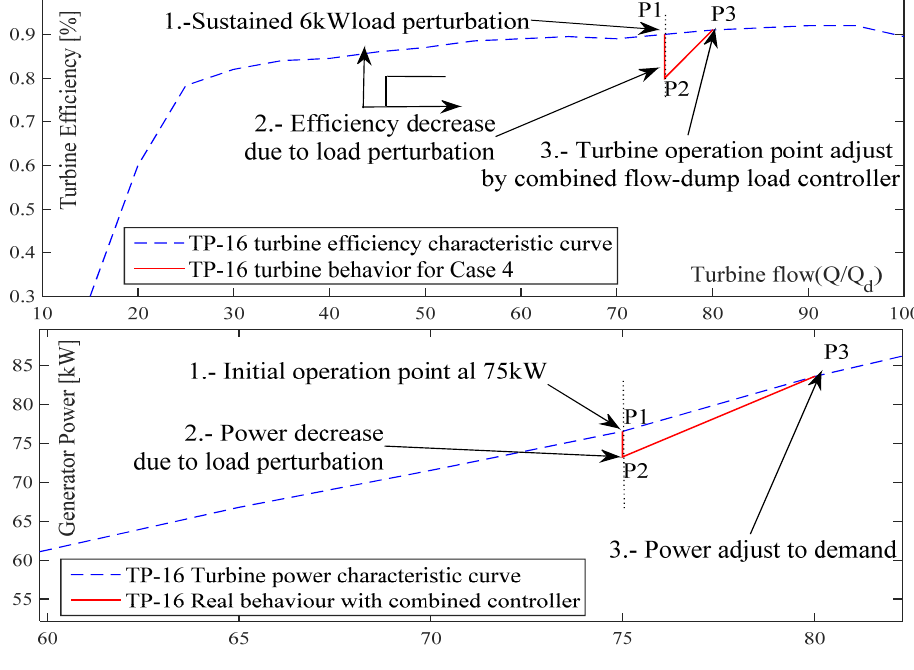
Figure 9. Turbine efficiency and power to Case 4.